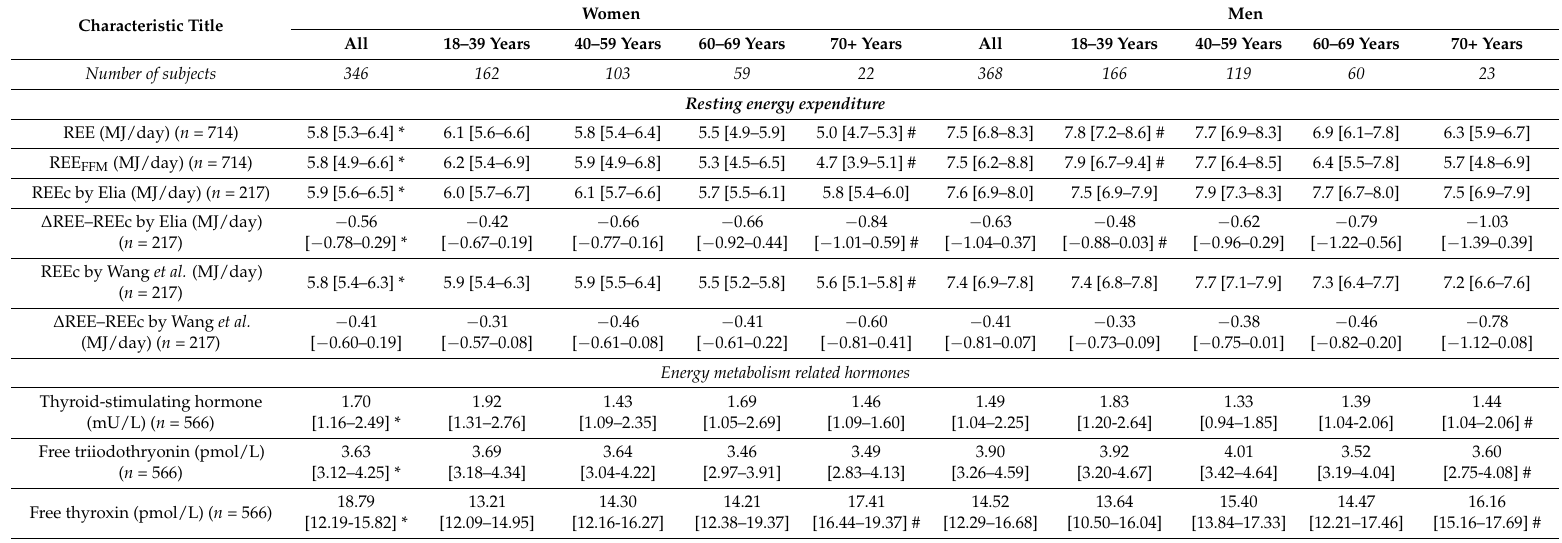
Table 2. Measured REEm and calculated REEc resting energy expenditure and differences between measured and calculated energy expenditure for the study population ( n = 714).